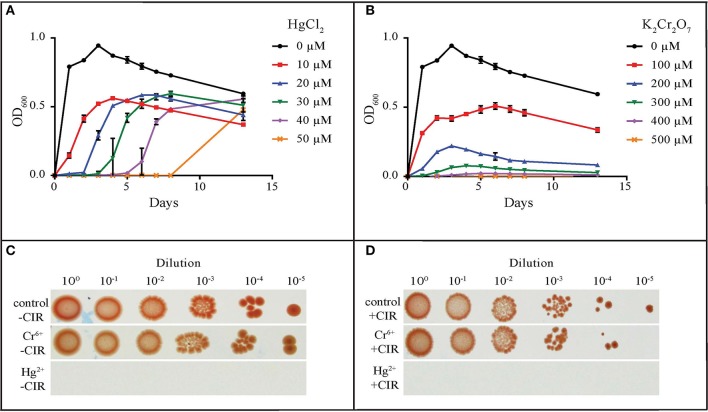
Resistance of R. taiwanensis MD1149 to HgCl2 and K2Cr2O7. Growth in liquid AM supplemented with (A) HgCl2 and (B) K2Cr2O7. (C) Growth of diluted cell suspension (OD600 ~0.9) on solid AM with no metals added (control), with 100 μM K2Cr2O7 (Cr6+), and with 30 μM HgCl2 (Hg2+), no CIR. (D) As for Panel (C), under 36 Gy/h (+CIR). For corresponding CrCl3 (Cr3+) results, see Table 1.